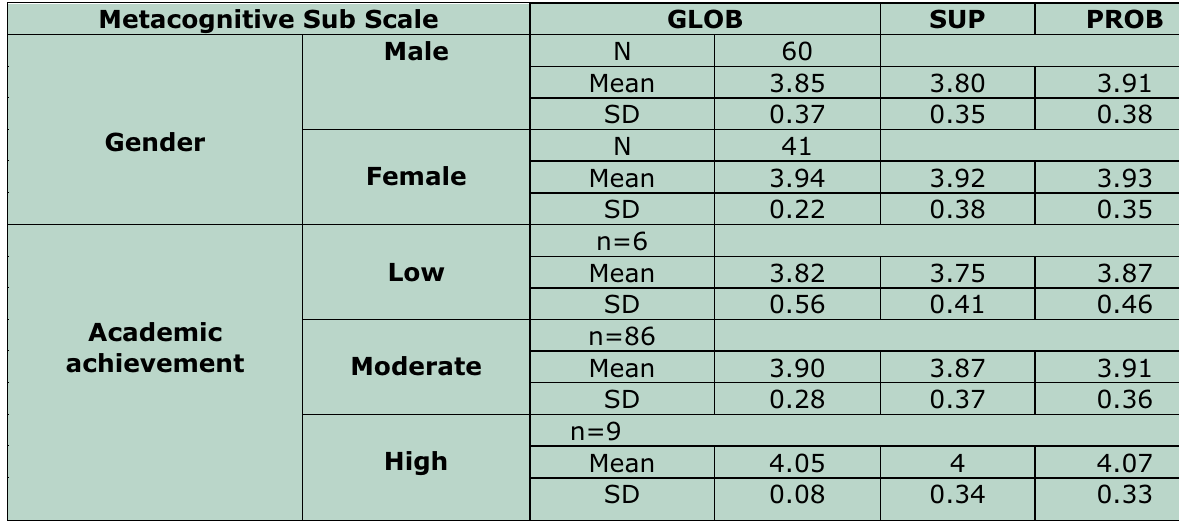
Table-IV: Descriptive Statistics of Gender and academic achievement for metacognitive awareness of reading